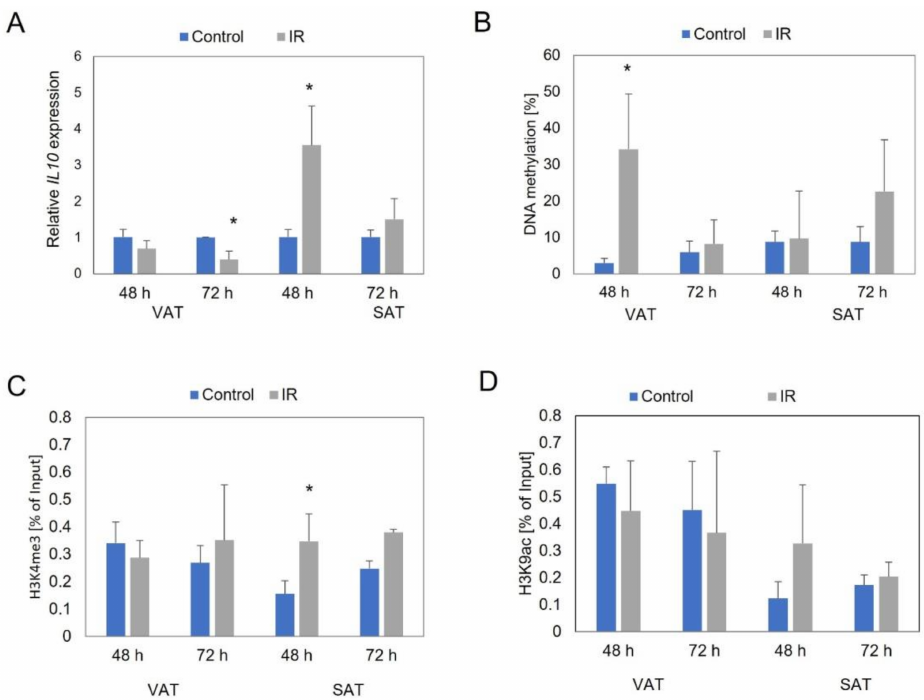
Figure 1. The IL10 expression ( A ), DNA methylation ( B ), histone methylation ( C ), and histone acetylation level ( D ) in visceral (VAT) and subcutaneous (SAT) derived control adipocytes and insulin resistant adipocytes (IR) after 48 and 72 h after insulin resistance induction. * p < 0.05.